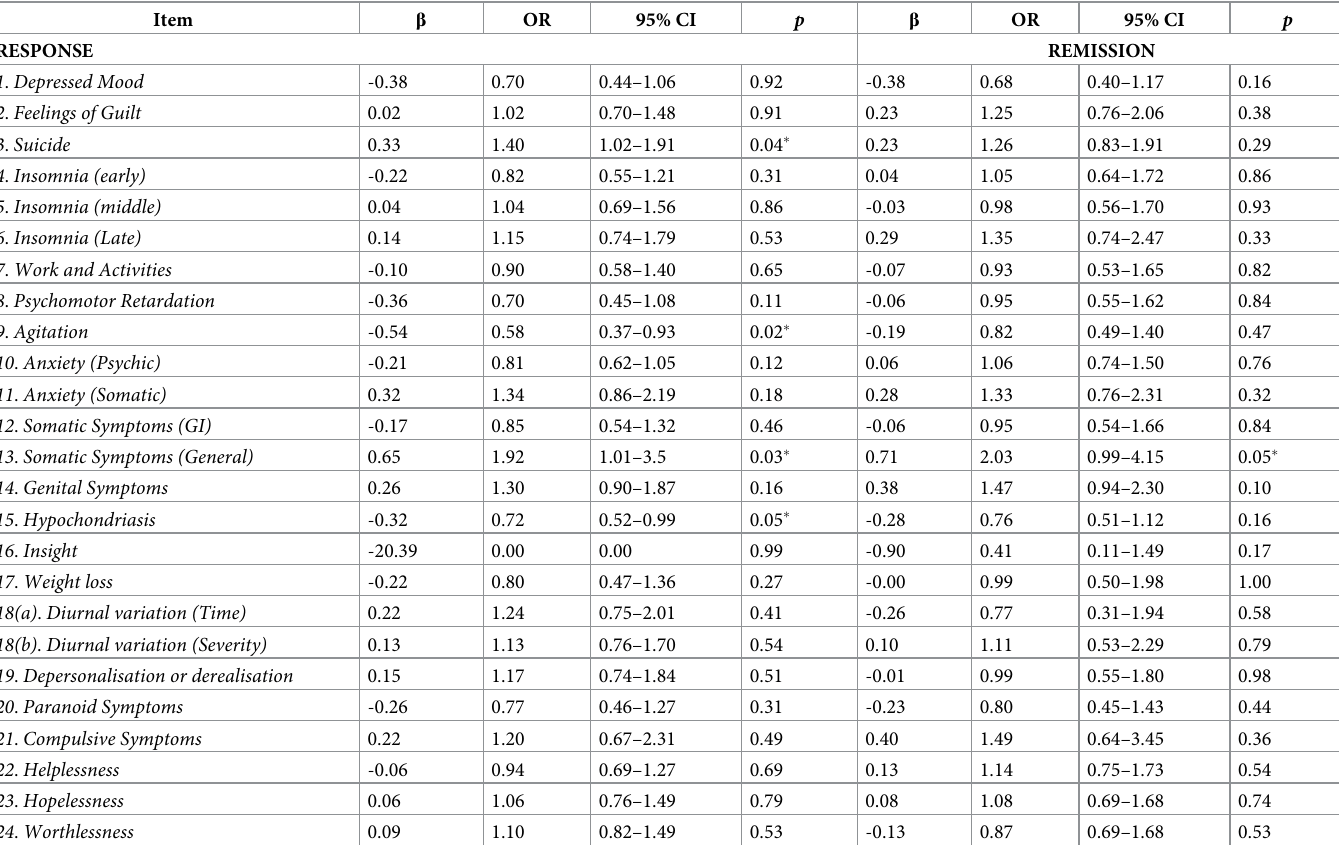
Table 6. Individual HAMD-24 items as predictors of